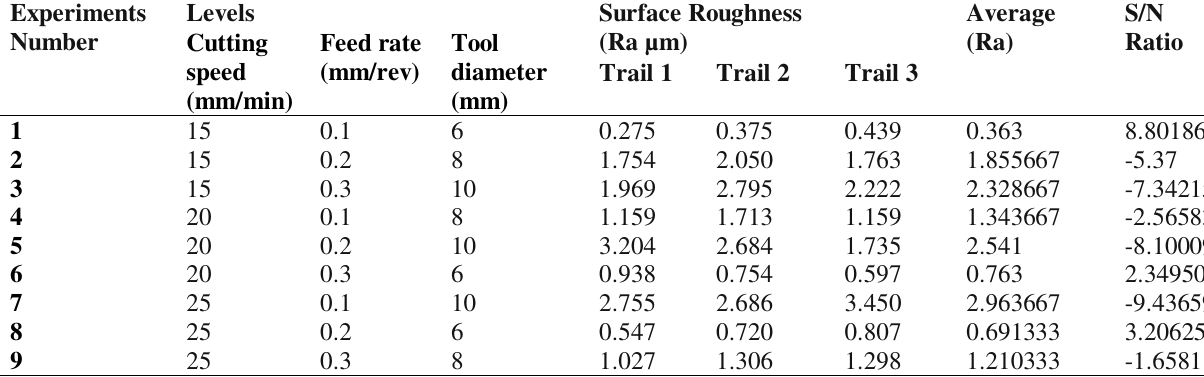
The Result of Surface Roughness (R a ) and (S/N) Ratio.